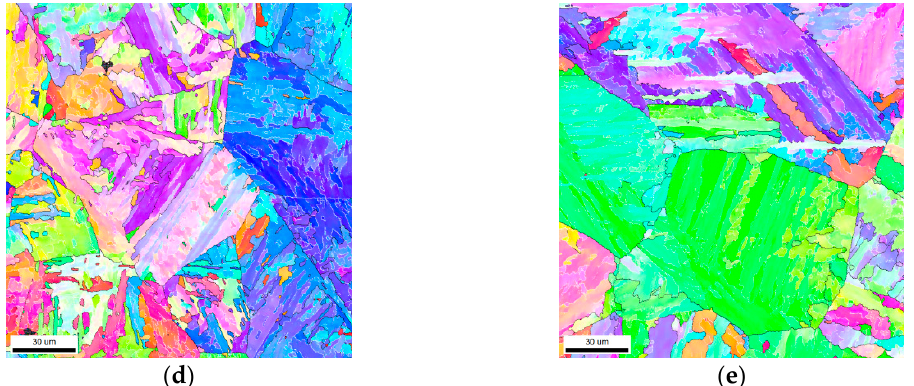
Figure 8. EBSD orientation images with grain boundaries color coded according to the magnitude of the misoriention: ( a ) 18 kJ/cm; ( b ) 25 kJ/cm; ( c ) 31 kJ/cm; ( d ) 44 kJ/cm; and ( e ) 81 kJ/cm.